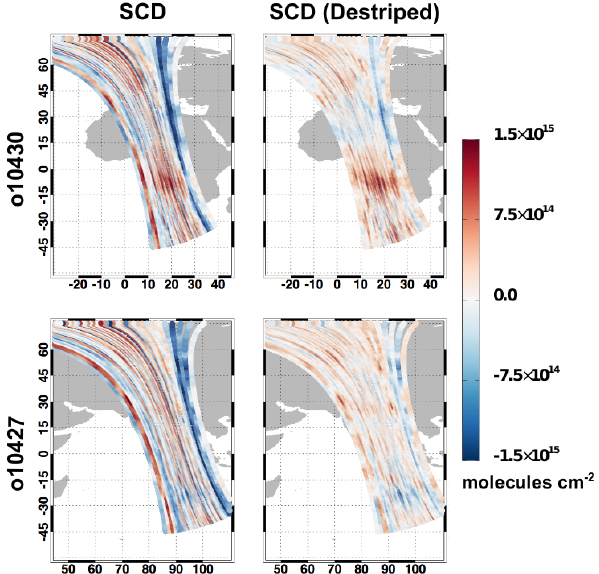
Figure 8. Left: retrieved glyoxal slant column densities (moleculescm − 2 ) using OMI data from orbits o10430 and o10427. Right: retrieved slant column density (moleculescm − 2 ) corrected for striping by subtracting the mean retrieved slant column between 20 and 30 ◦ N for each cross-track